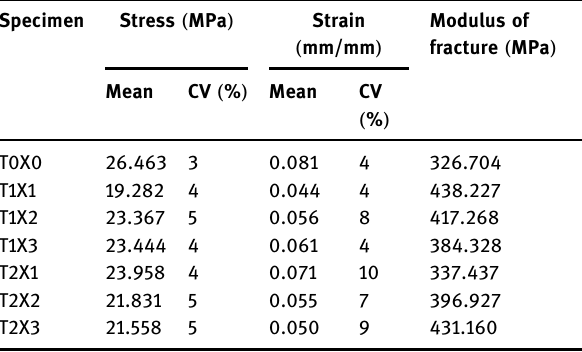
Table 5: Stress and strain of epoxy resin after quenching treatment